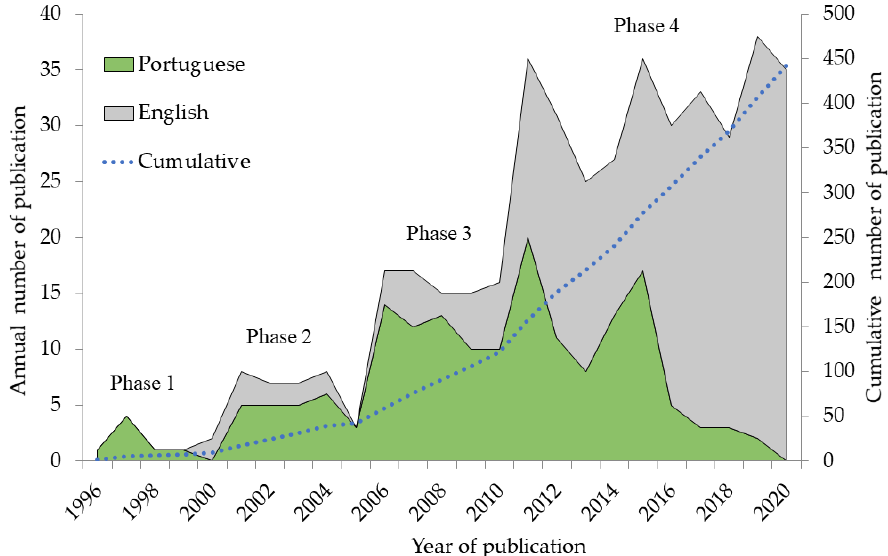
Figure 3. Number of publications in precision agriculture over the past 25 years in Brazil. Four phases of PA research in Brazil were identified based on the evolution of the number of published papers.